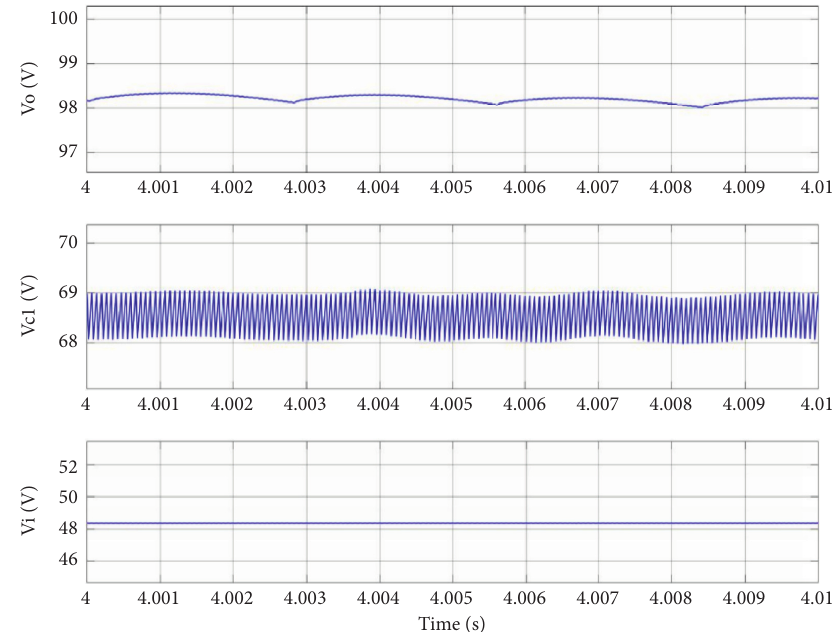
Figure 13: Output voltage V o , capacitor voltage V c1 , and battery voltage V i during boost mode.